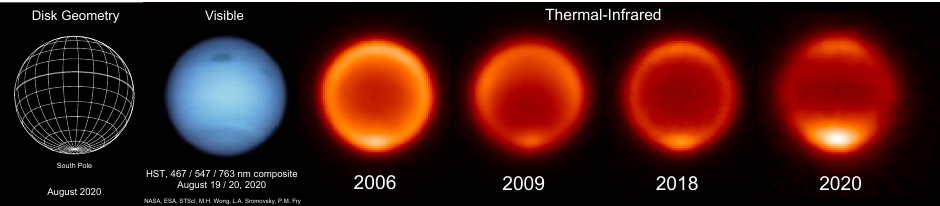
Figure 19. A sequence of mid-infrared images showing the variation of Neptune at roughly 12 µ m in different years, along with disk geometry and a Hubble Space Telescope (HST) visible image for comparison. The mid-infrared images were taken from VLT-VISIR (2006, 2009, 2018) and Subaru- COMICS (2020) [74]. The sequence shows a global decline in radiances accompanied by dramatic warming at Neptune’s south pole between 2018 and 2020. The HST image was taken in 2020, three weeks after the Subaru-COMICS image. (HST Image credit: NASA, ESA, STScI, M.H. Wong (University of California, Berkeley), and L.A. Sromovsky and P.M. Fry (University of Wisconsin-Madison). While global temperatures dropped, images sensitive to 12- µ m emission from strato- spheric ethane showed a dramatic surge in radiance from Neptune’s south pole between 2018 and 2020–again attributed to a rise in temperatures ( ∼ 13 K) inferred from nearly contemporaneous H 2 S(1) spectra [74]. This warming circumpolar vortex was combined with a drop in temperatures at nearly all other latitudes (see Figure 20). Radiative